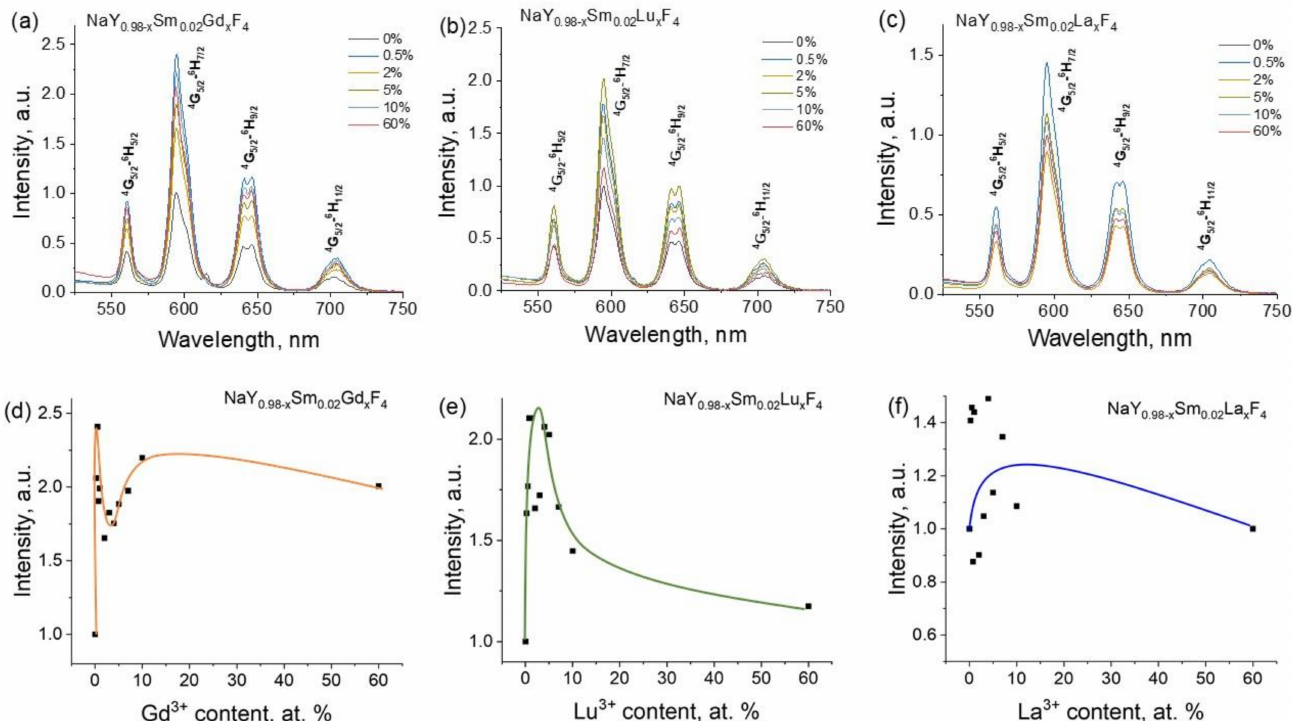
Figure 10. The emission spectra of synthesized compounds NaY 0.98 − x Sm 0.02 Ln x F 4 (Ln = Gd, Lu, La on ( a – c ), respectively), upon 400 nm excitation; dependence of integral intensities of 5 G 5/2 → 6 H 7/2 emission band (595 nm) on Gd 3+ ( d ), Lu 3+ ( e ), and La 3+ ( f ) content) relative to the NaY 0.98 Sm 0.02 F 4 sample.